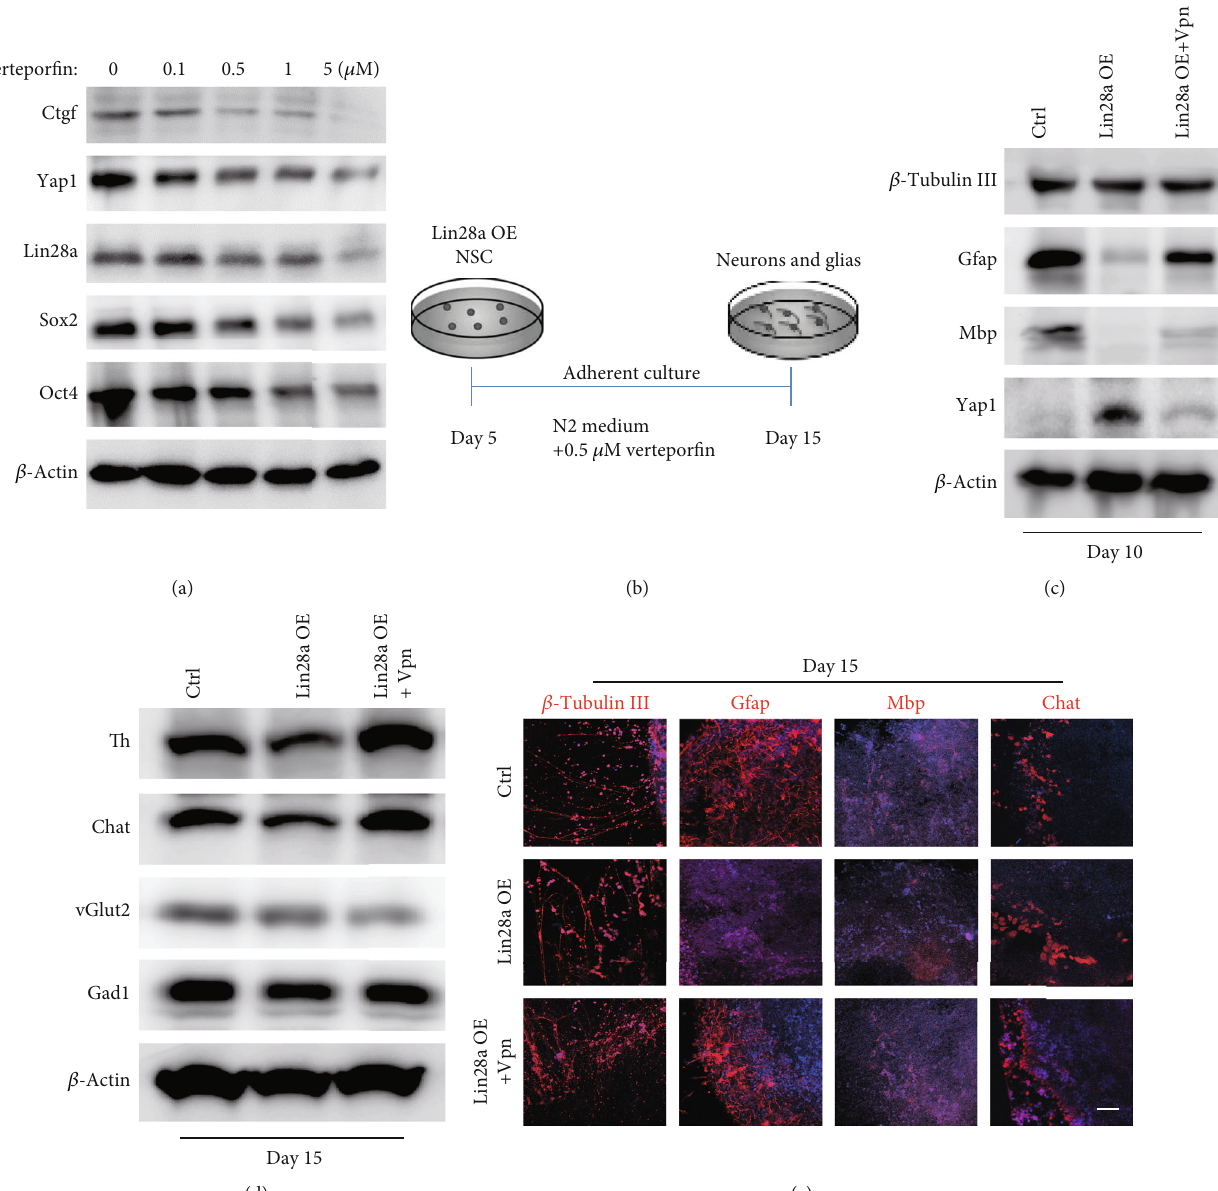
Figure 5: Inhibition of Yap1-Tead interaction using vertepor fi n partially rescued the glial cell lineage di ff erentiation defect of Lin28a/b OE mouse ESCs. (a) Western blot analyses of total proteins from Ctrl mouse ESCs treated with di ff erent concentrations of Yap1-Tead interaction inhibitor (vertepor fi n) using the indicated antibodies. (b) A schematic drawing of the di ff erentiation assay from neural stem cells (day 5) to neuronal and glial lineage cells (day 15) combining with vertepor fi n. (c) Western blot analyses of total proteins from Ctrl and Lin28a OE mouse ESC di ff erentiated cells (treated with DMSO and Vertepor fi n, respectively) on day 10 using the indicated antibodies. (d) Western blot analyses of total proteins from Ctrl and Lin28a OE mouse ESC di ff erentiated cells (treated with DMSO and vertepor fi n, respectively) on day 15 using the indicated antibodies. (e) Immuno fl uorescence staining of the Ctrl and Lin28a OE mouse ESC di ff erentiated cells (treated with DMSO and vertepor fi n, respectively) on day 15 using the neuronal marker β -tubulin III, glial markers Gfap and Mbp, and neuronal subtype markers chat. Cell nuclear was stained with DAPI. Scale bar, 200 μ